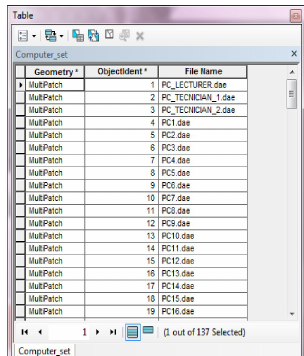
Figure 12. The attribute table was created and every 3D model